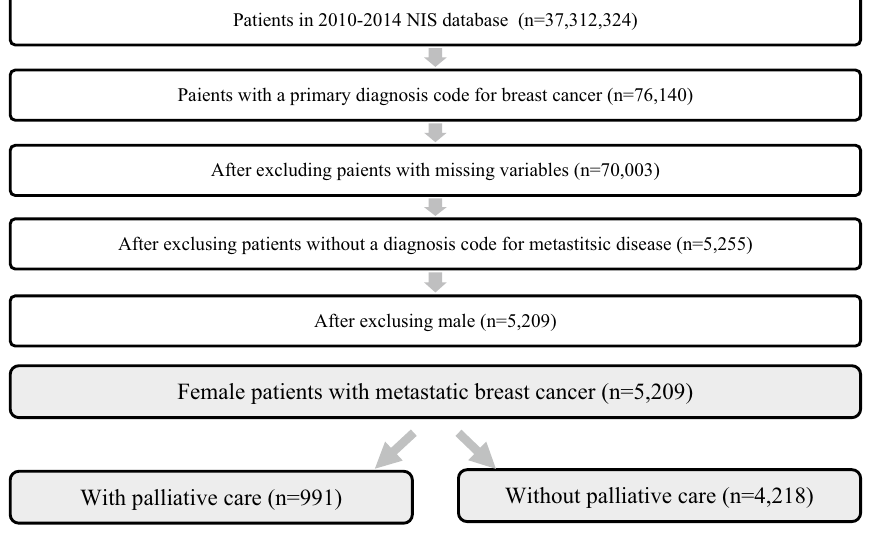
Figure 1. Patient selection